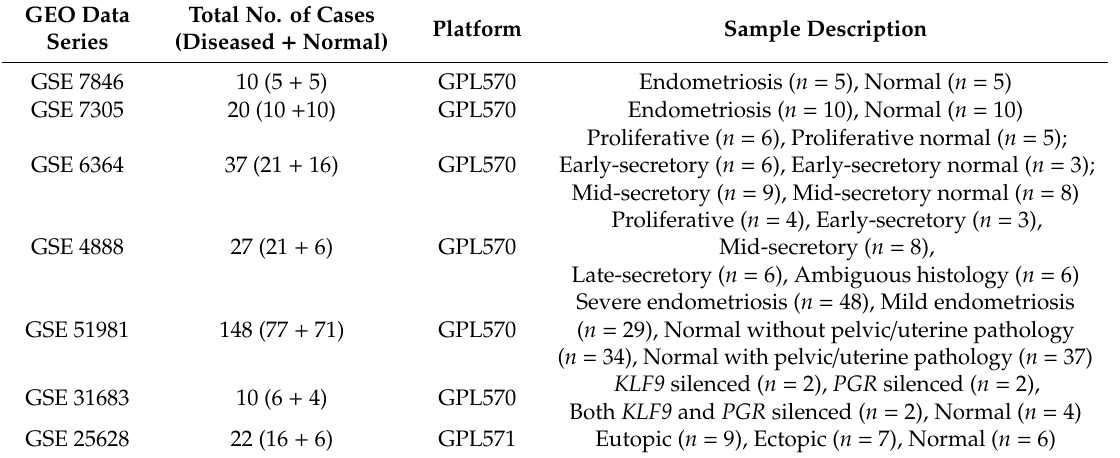
Gene expression Omnibus (GEO) data series, platform, and sample description of endometrium-based expression studies (total 156 endometriosis patients + 118 normal